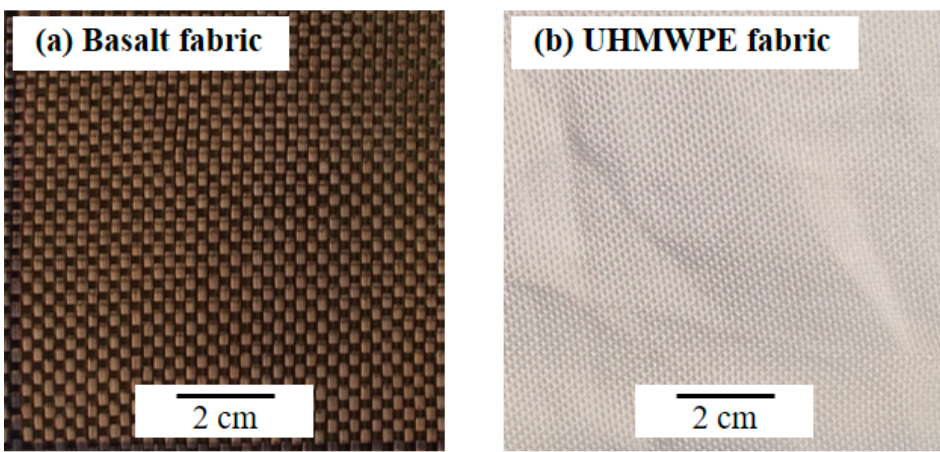
Figure 1. Basalt and UHMWPE fabrics were used in experiments. ( a ) Basalt fabric. ( b ) UHMWPE fabric.